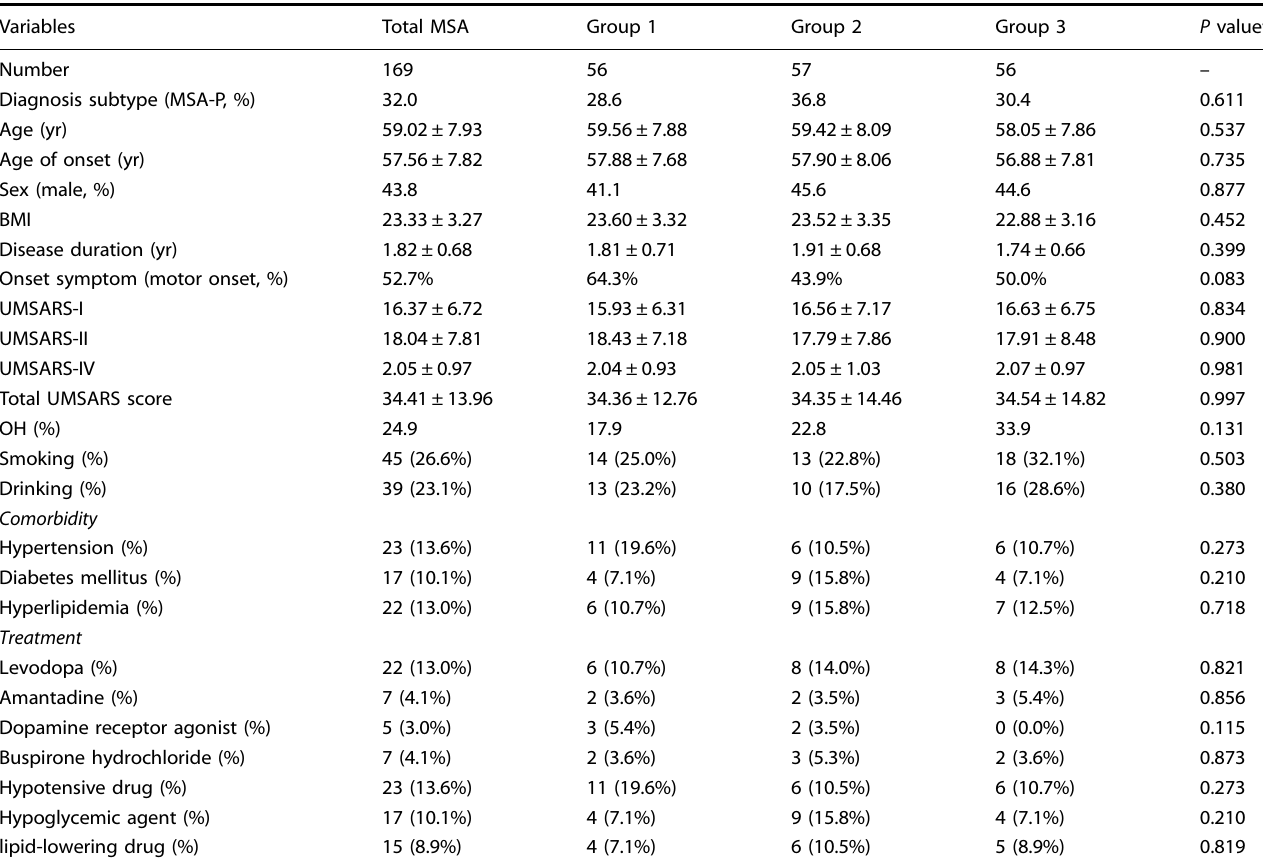
Table 2. Demographic and clinical features of patients with MSA between the three groups according to NLR